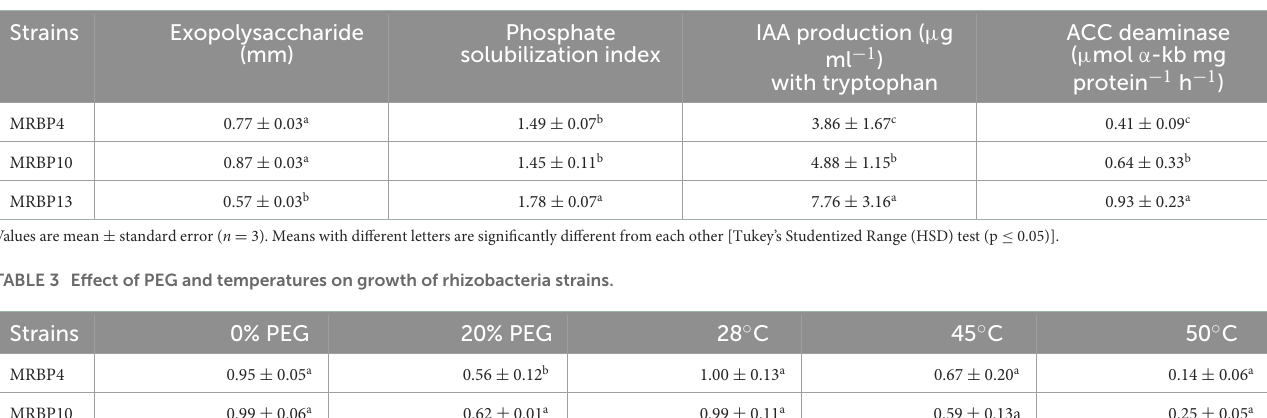
TABLE 2 Evaluation of rhizobacteria strains for PGP traits.